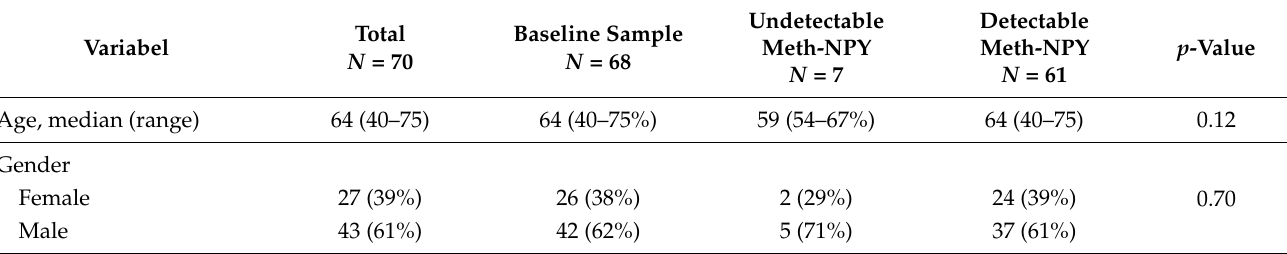
Table 1. Baseline